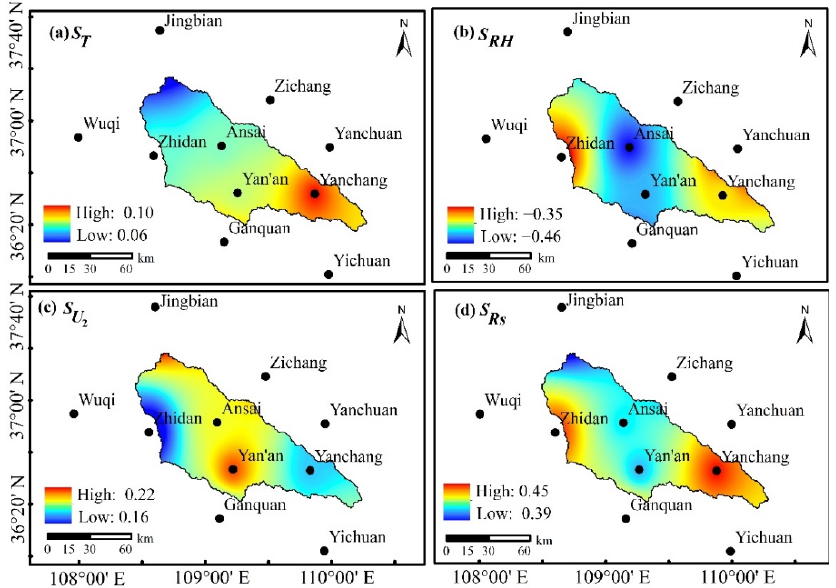
Figure 4. Spatial distribution of sensitivity coefficients of ET 0 to meteorological factors: ( a ) air temperature, ( b ) humidity, ( c ) wind speed at 2 m height, ( d ) solar radiation.